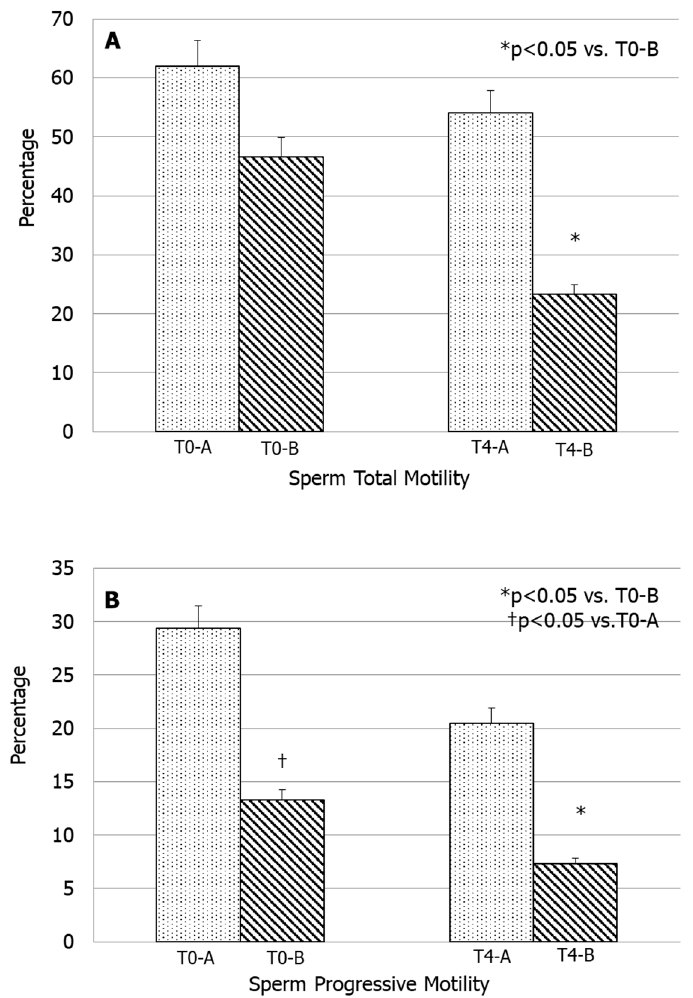
Figure 2. Total and progressive sperm motility of the two examined groups at T0 and T4.